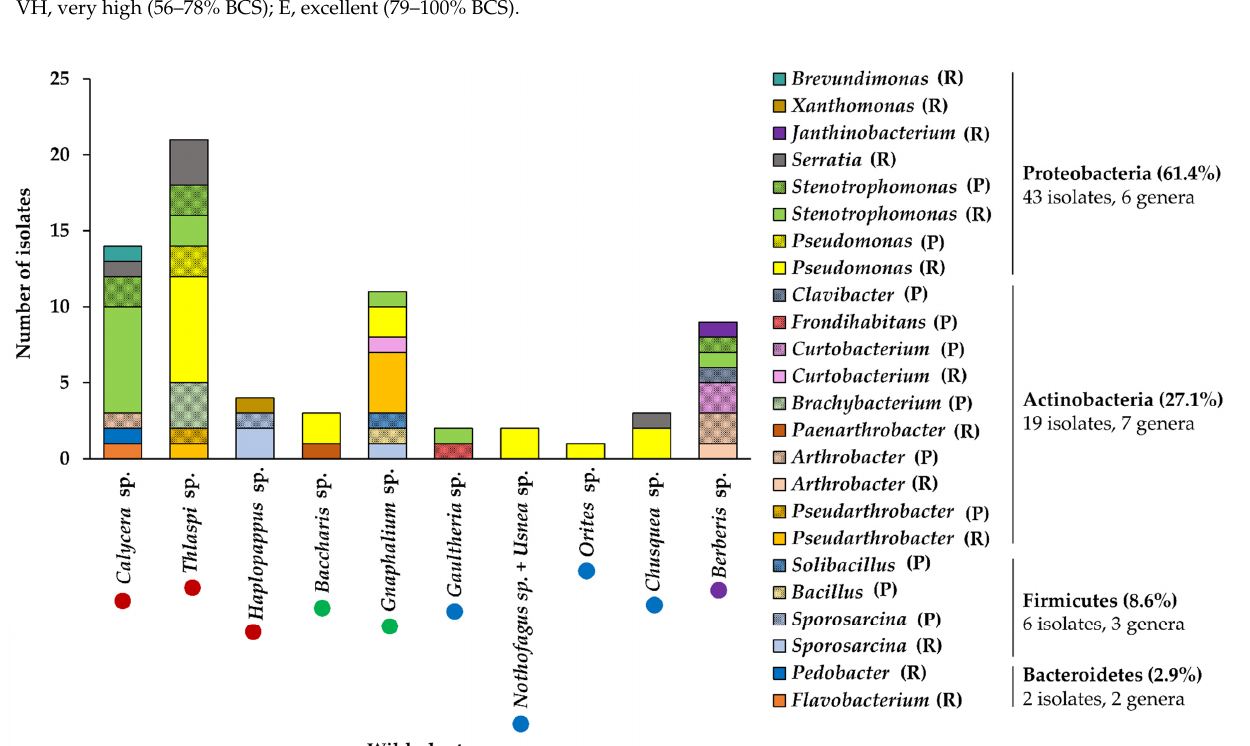
Gaultheria sp. (Gp)